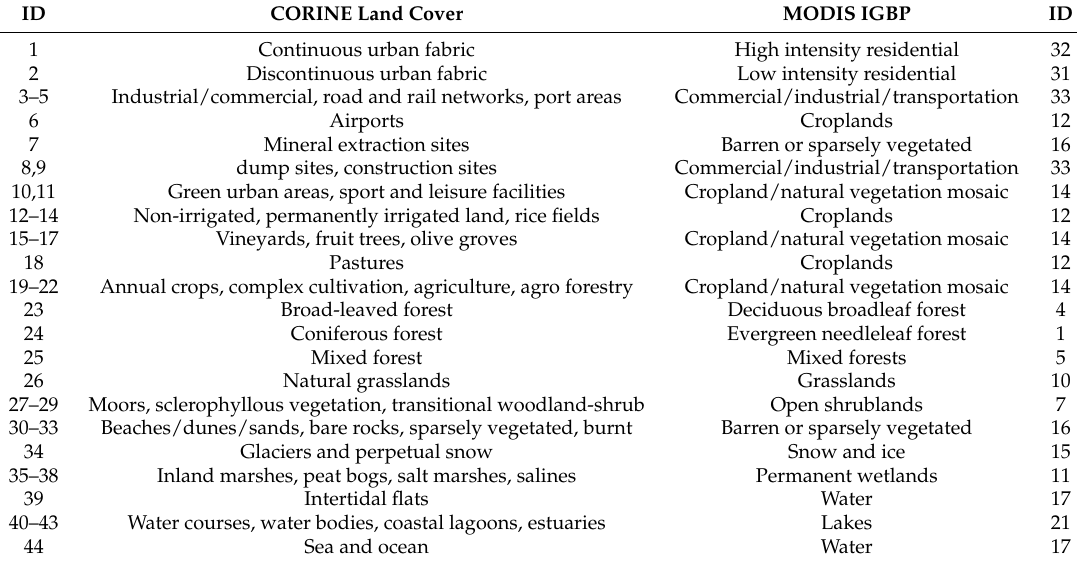
Table 3. Reclassification from CORINE land cover to Moderate Resolution Imaging Spectroradiometer (MODIS) International Geosphere–Biosphere Programme (IGBP) including lakes and three urban